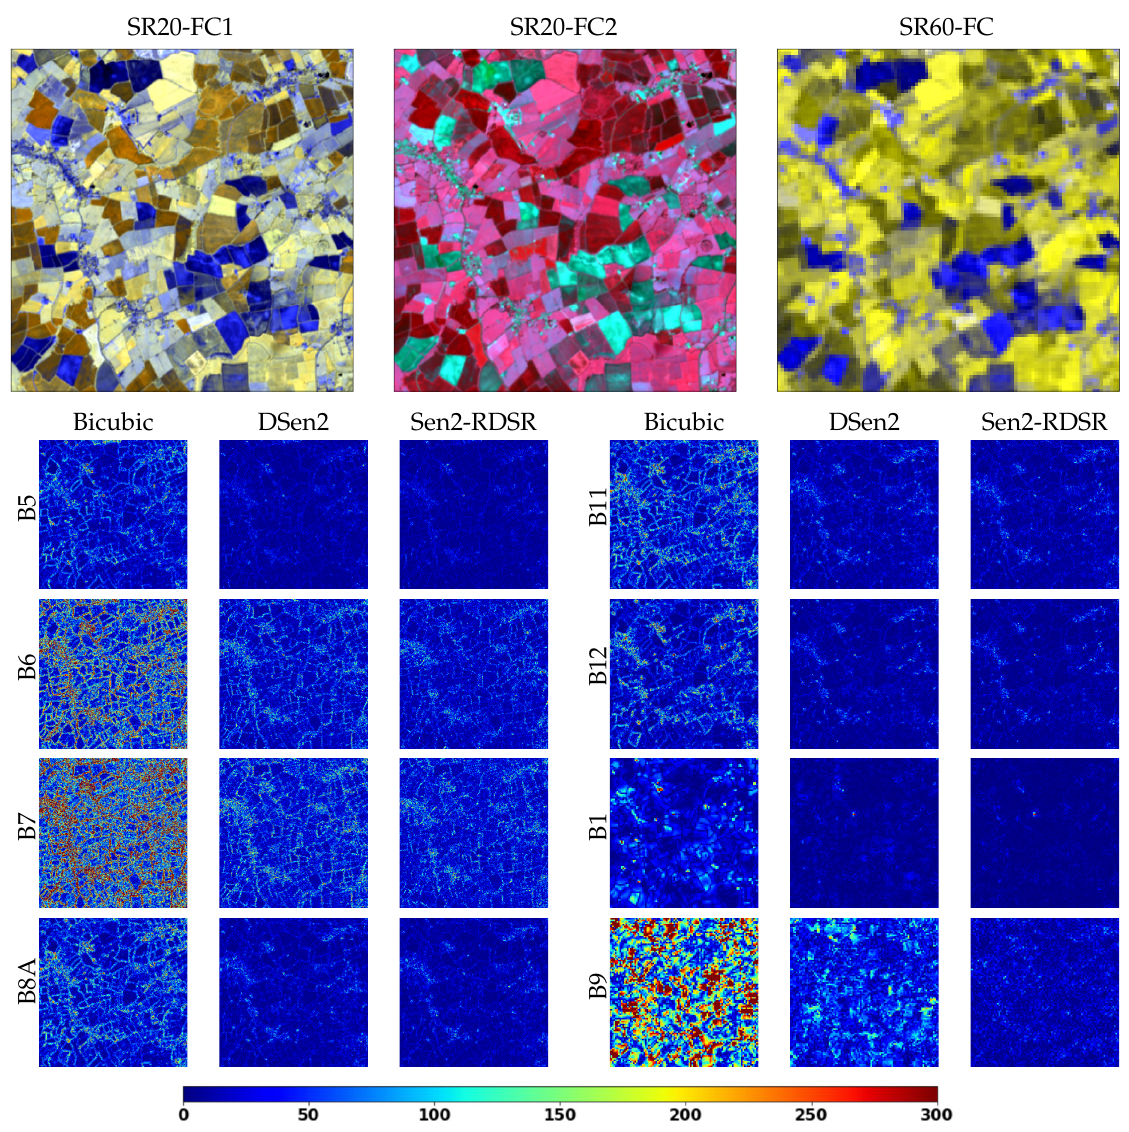
Figure 7. Comparison of the absolute difference between the target and the SR image per band. A small region of 100 × 100 pixels was selected to show the difference between the models. The first row shows the color composite for SR20 FC1:{B5,B6,B7}, FC2:{B12,B11,B8A} and SR60 {B9,B9,B1} images. The remaining rows show the error maps for the bicubic interpolation, DSen2 (images were generated from its public GitHub repository), and our